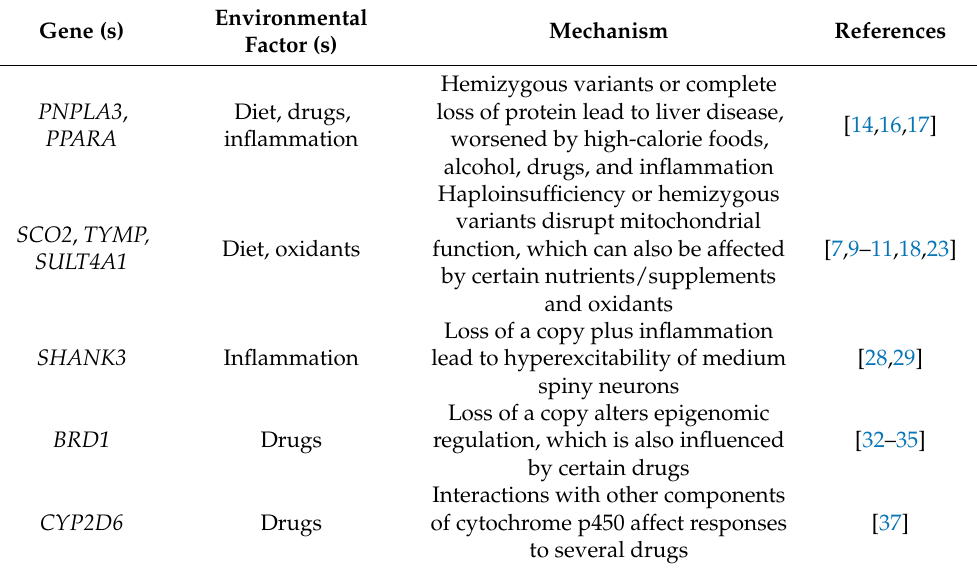
Table 1. Possible contributions of environmental factors to Phelan–McDermid syndrome clinical